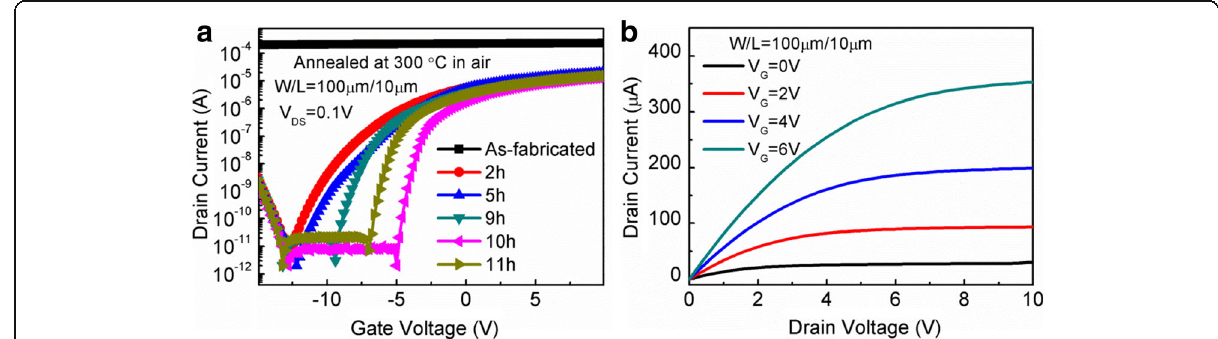
Fig. 6 a Transfer characteristics of the In 2 O 3 TFTs annealed at 300 °C in air for different time; b Output characteristics of the In 2 O 3 TFT annealed at 300 °C in air for 10